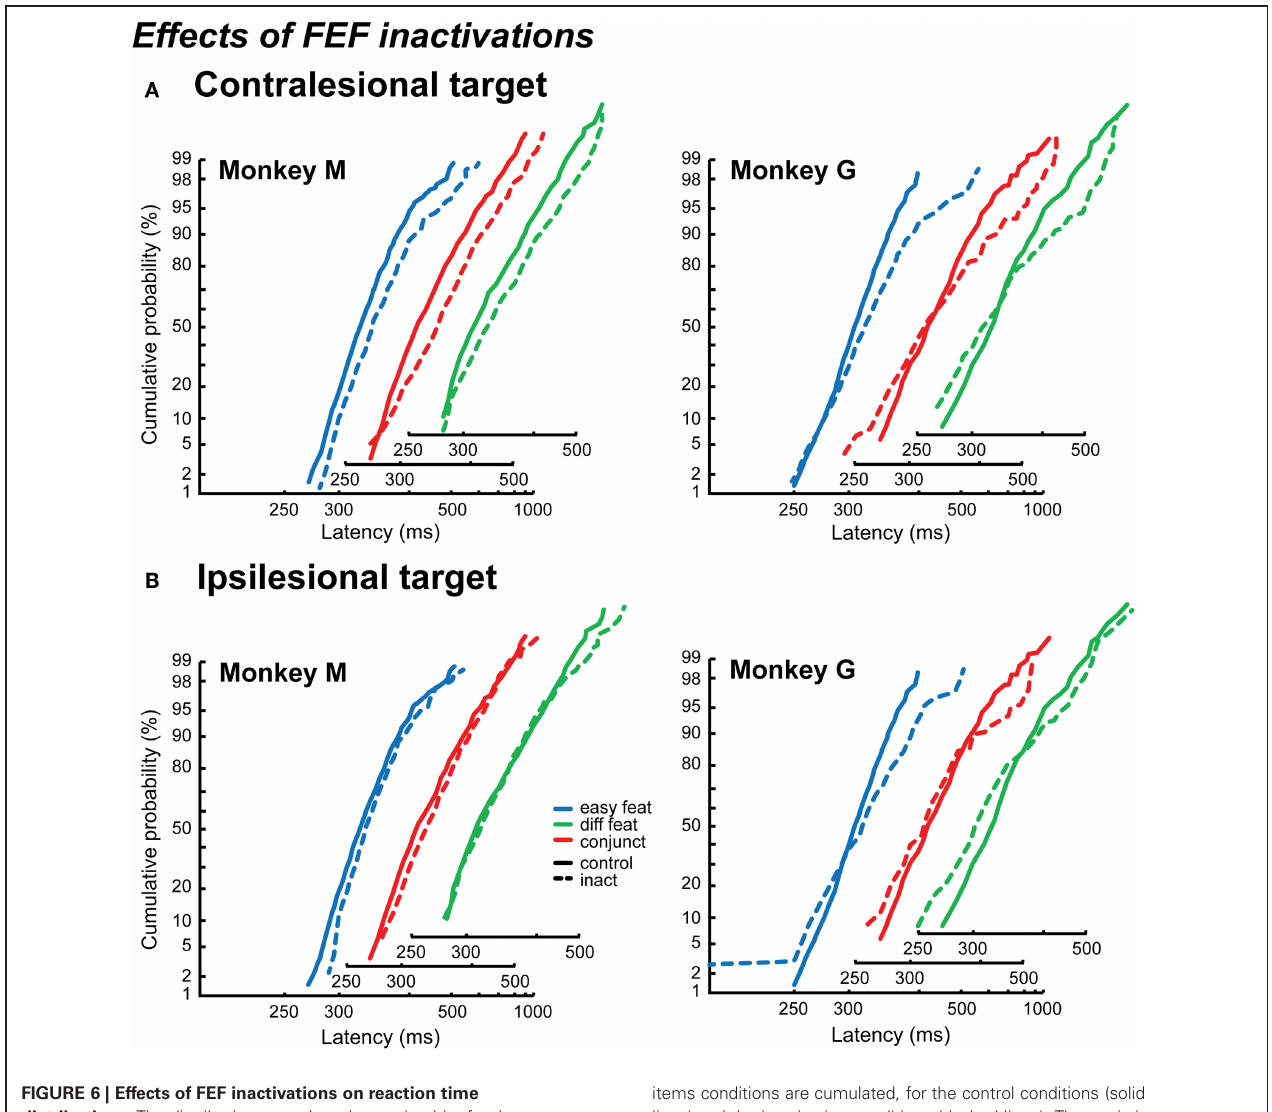
FIGURE 6 | Effects of FEF inactivations on reaction time distributions. The distributions are plotted as reciprobits for the contralesional targets (A) and the ipsilesional targets (B) , in Monkey M (left) and Monkey G (right). The different numbers of